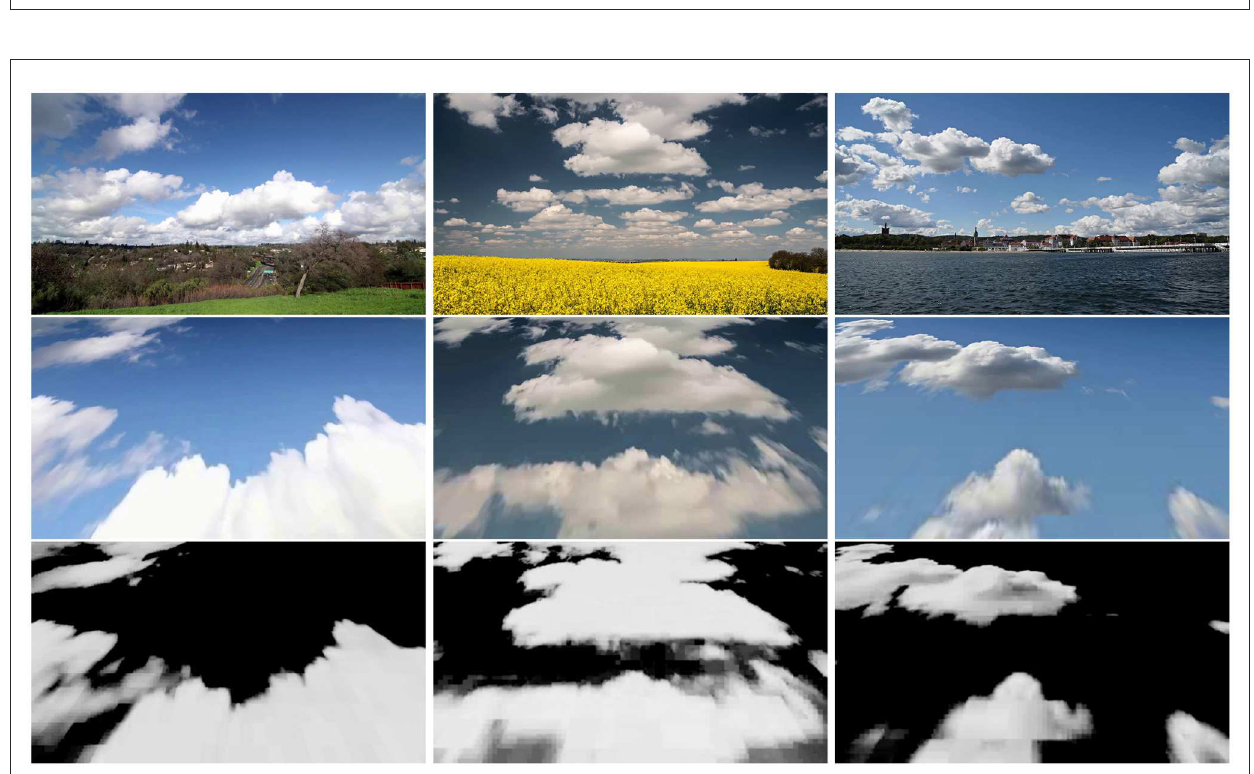
FIGURE6 Source images (top) , perspective corrected and scaled images (middle) , and final cloud maps (bottom) . Each column represents a different